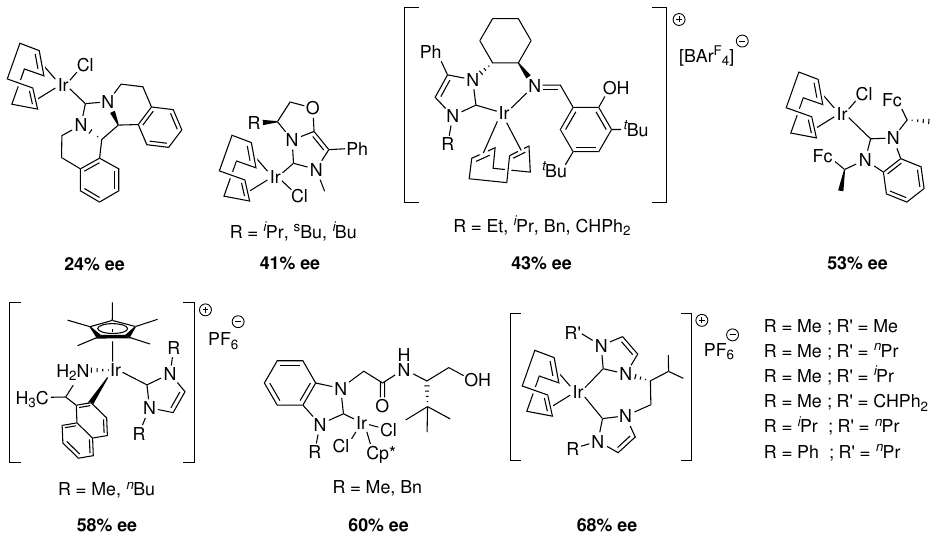
Figure 2. A few examples of previously reported iridium NHC catalysts and their optimal ee’s for asymmetric transfer hydrogenation of various ketone